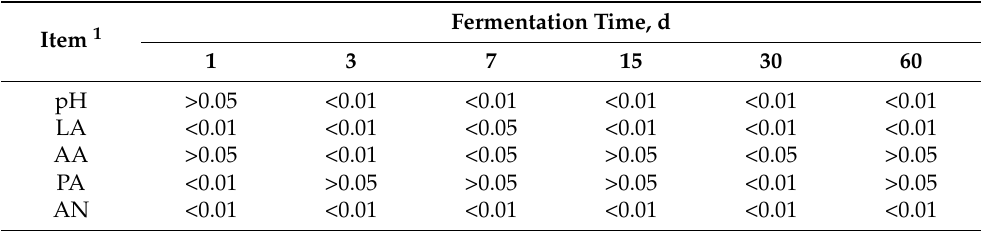
Table 6. Statistical analysis for the fermentation profile variables of fresh-alfalfa and ensiled-alfalfa FTMR treated with different additives at each ensiling